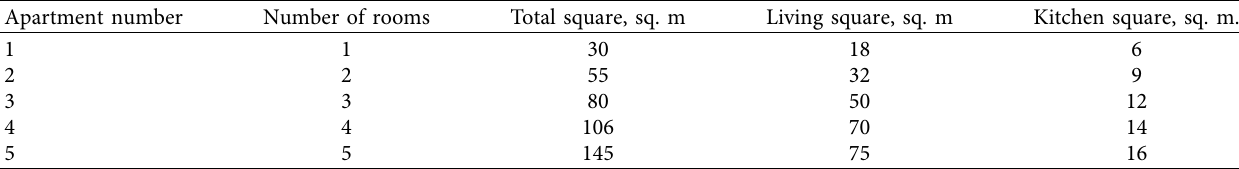
Figure 2: Neural network testing results: comparison of declared (actual) and estimated apartment values using the neural network. Table 1: Input parameters of the model that characterize the apartments under